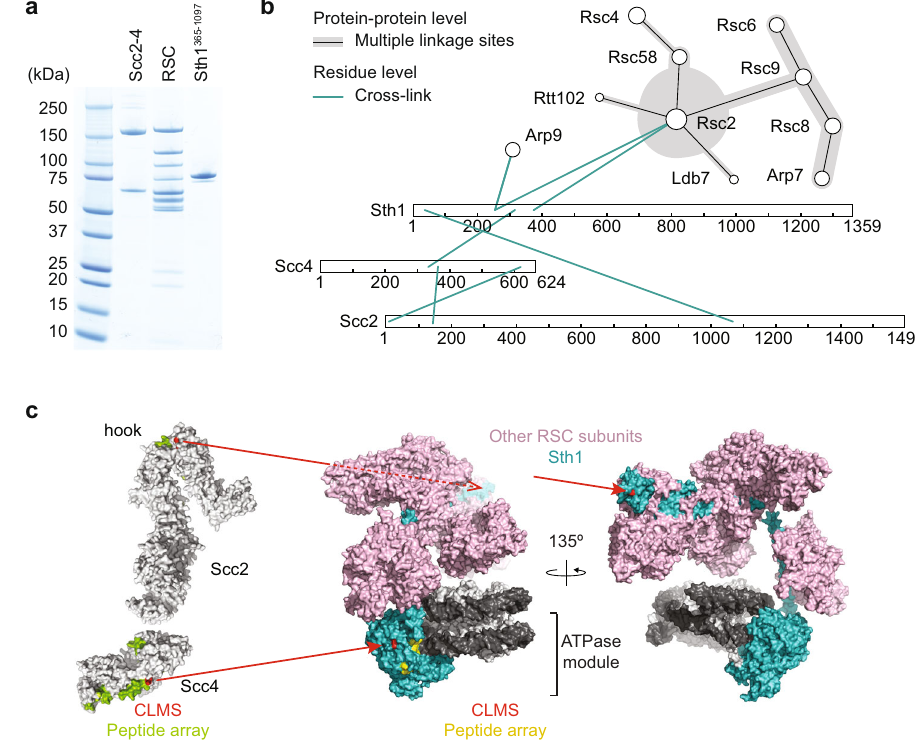
Fig. 1 | Protein interactions between the RSC chromatin remodeler and the cohesin loader. a Puri fi ed Scc2-Scc4 and RSC complexes, as well as the Sth1 365 – 1097 fragment were analyzed by SDS-PAGE followed by Coomassie Blue staining. A representative gel from three puri fi cations is shown. b Protein contacts, detected by CLMS, within the RSC complex and between RSC and the cohesin loader. Data from two biological repeat experiments was combined. Sth1, Scc4 and Scc2 are